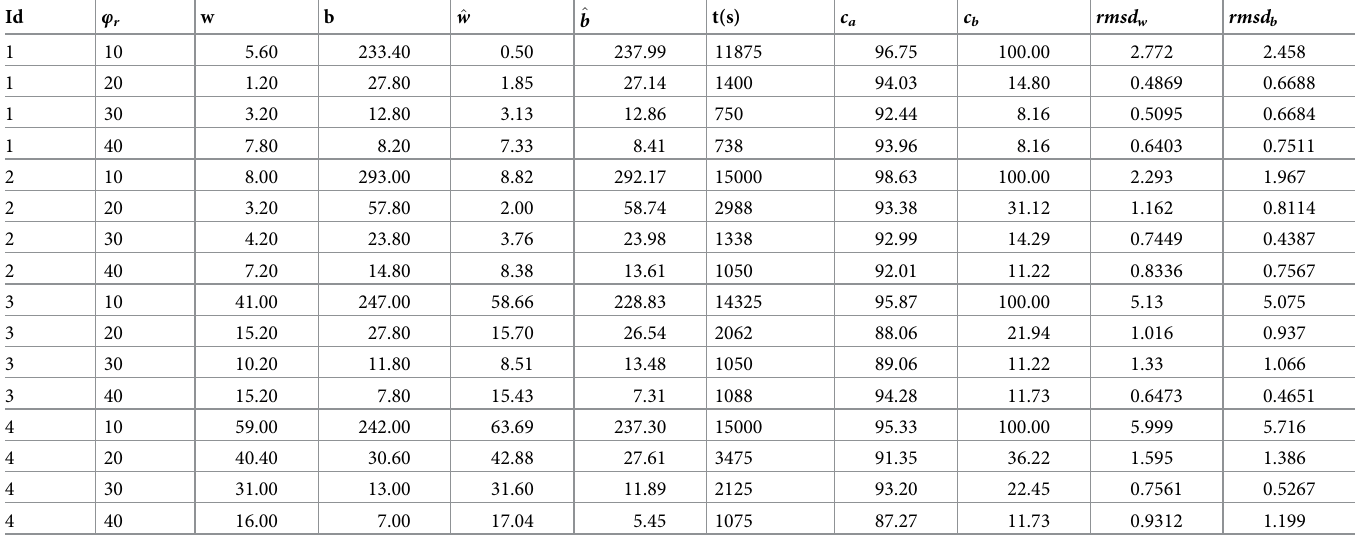
Table 1. Selection of results for four maps of the simulation. All maps are delimited with perimeter walls. The first map (Id 1) is an empty hall of 100x100m (left map of Fig 3a). Map 2 is a 100x200m empty hall. Map 3 is half divided hall with one wall and only a pass door. Map 4 is a complex 100x100m hall, with multiple walls and corridors (middle right map of Fig 3a). The entropy for each map ordered by increasing Id is (0.2405, 0.0027, 0.2817, 0.4639). The average of area covered for 10 runs and the average of time required to cover this area is shown. The maximum time allowed for simulation is 15000s. This time will be shorter if the swarm cover (using the c a metric) the 95% of the area. Furthermore, the number of individuals in states wander and beacon w , b for the simulation and for the mathematical model ð ^ w ; ^ b Þ is presented. Two dif- ferent covering metrics are shown: c a , the percentage of terrain that is covered by any individual of the swarm in any time and c b , that indicates the percentage of area cov- ered by individuals in the final iteration of the behaviour, assuming a detection range of 10m per individual. Finally, the measure of the differences between the number of individuals in each state predicted and simulated (using root-mean-square deviation, RMSD) is also